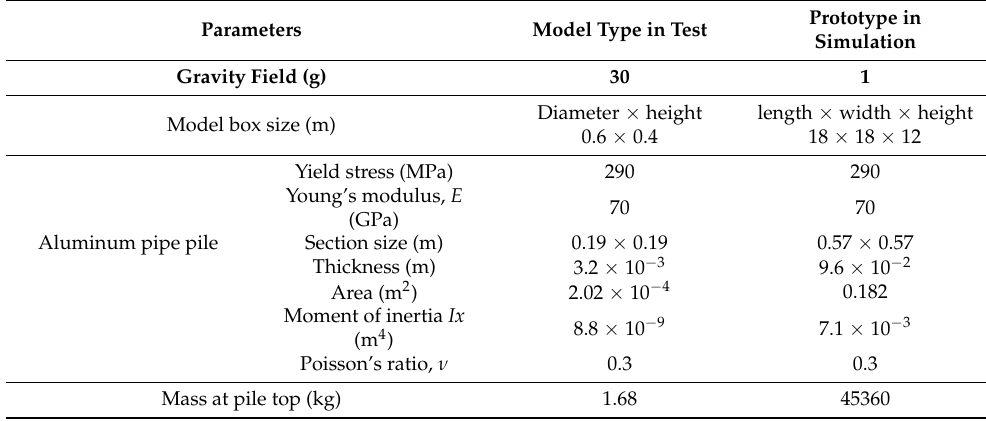
Figure 2. Sectional view of laminar box and model piles with data acquisition equipment (PPTn: pore presur test number; ACC: acceleration). Table 1. Parameters of model pile and corresponding prototype (satisfying scaling law).